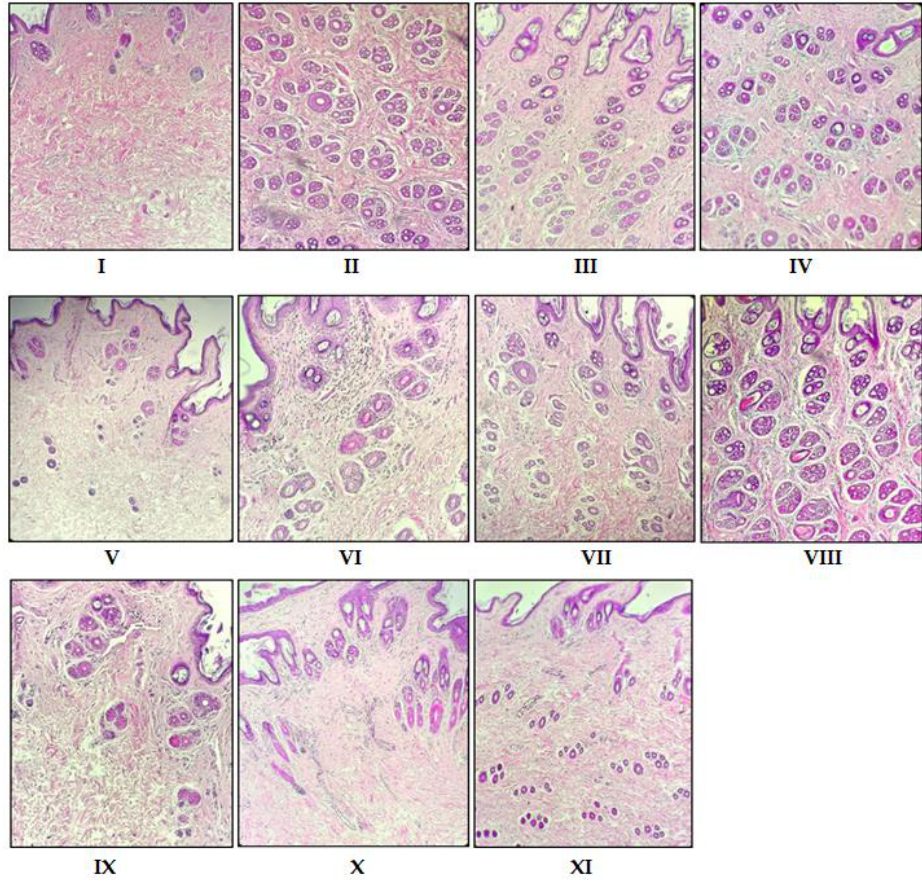
Figure 2. Graph of the calculation of hair follicular density and A/T ratio.